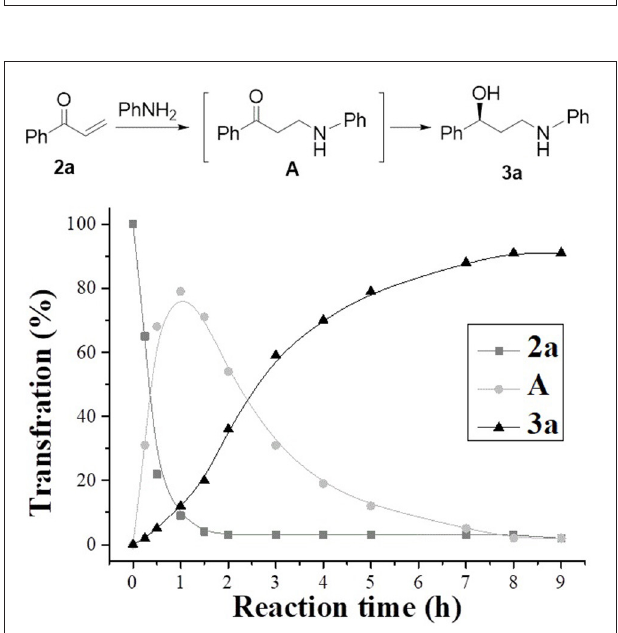
FIGURE 6 | Time course of the aza–Michael addition/ATH of 1–phenylprop − 2–enone and aniline to ( S ) − 1–phenyl − 3–(phenylamino) propanol